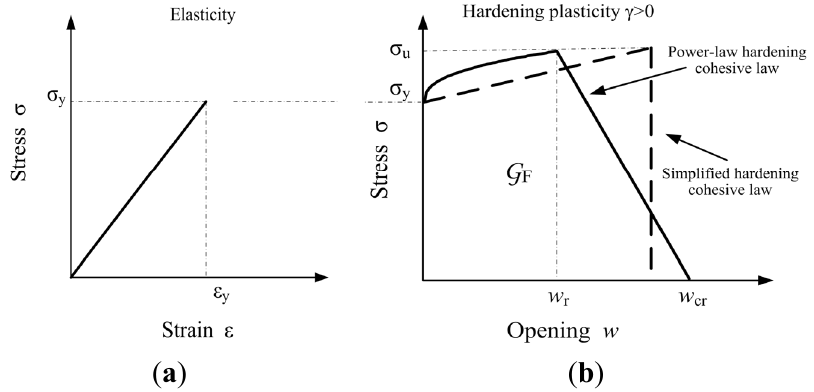
Figure 8. Constitutive laws according to the cohesive/overlapping crack model: ( a ) linear-elastic stress vs. strain relationship for the undamaged material, and ( b ) hardening stress vs. displacement law for the damaged and/or yielded material (followed by a linear softening